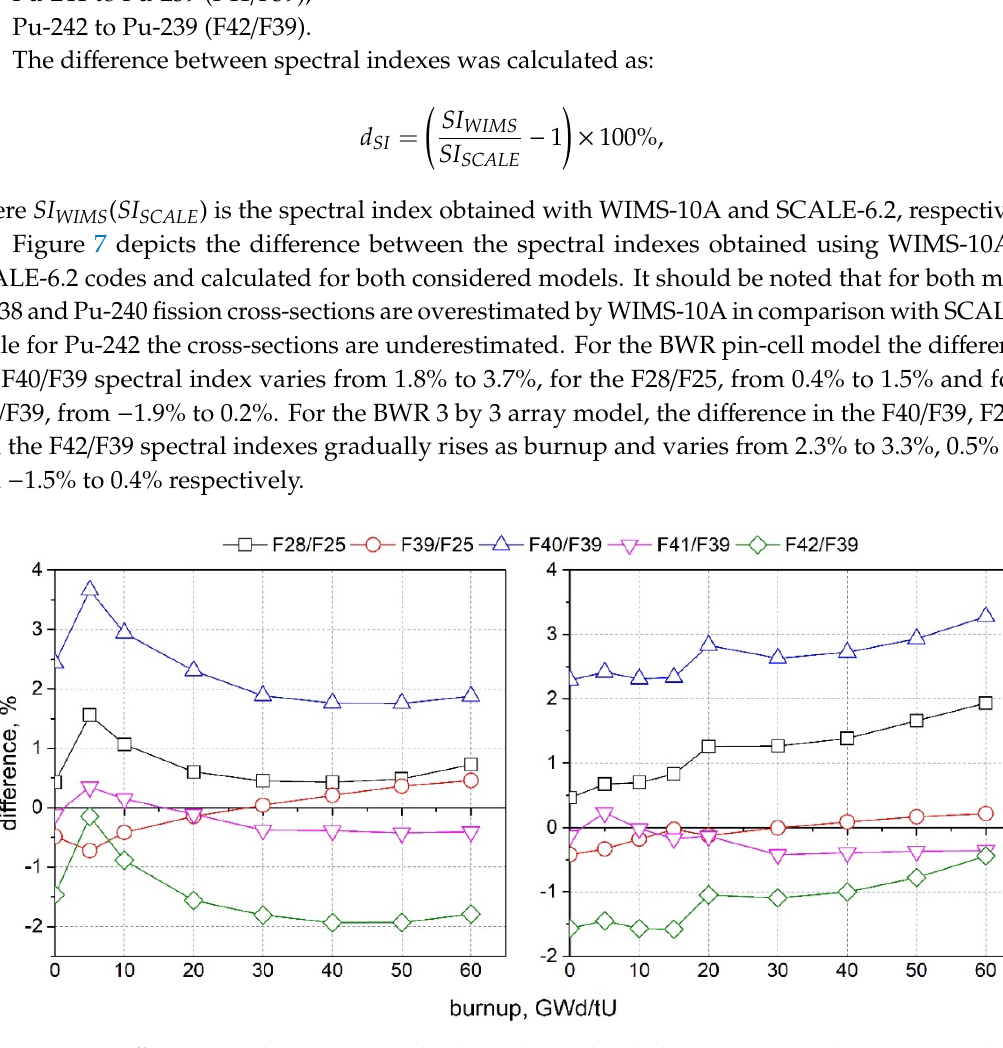
Figure 7. Di ff erence in % between spectral indexes obtained with the WIMS-10A and SCALE-6.2 codes Figure 7. Difference in % between spectral indexes obtained with the WIMS-10A and SCALE-6.2 for the BWR pin-cell ( right ) and BWR 3 by 3 array ( left ) codes for the BWR pin-cell ( right ) and BWR 3 by 3 array ( left ) models.